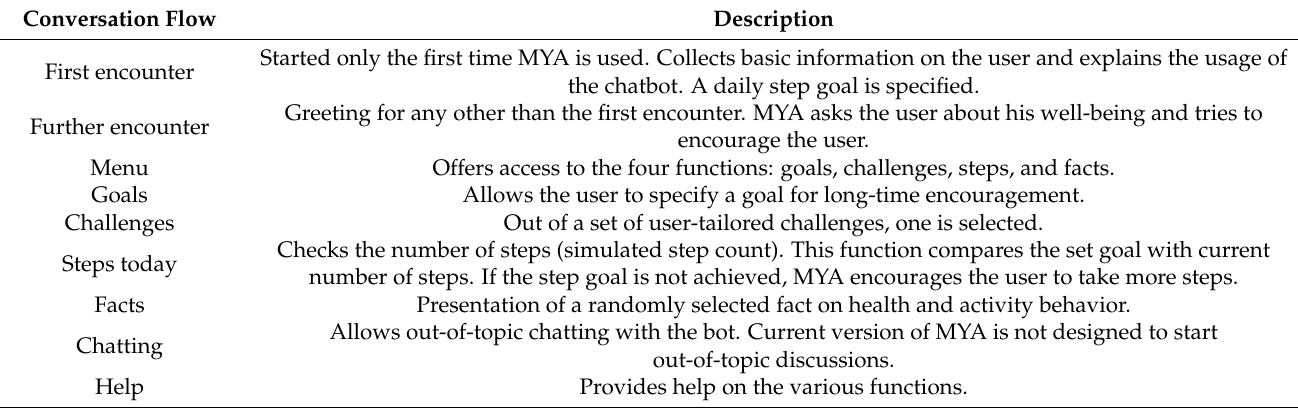
Table 1. Implemented conversation flows of